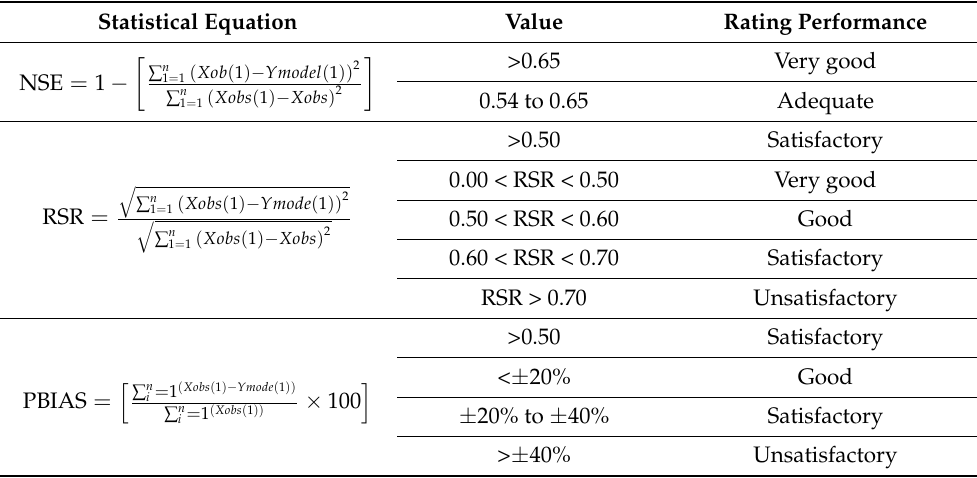
Table 5. The SWAT statistical equations used for calibration and validation processes and their level of performance. Statistical